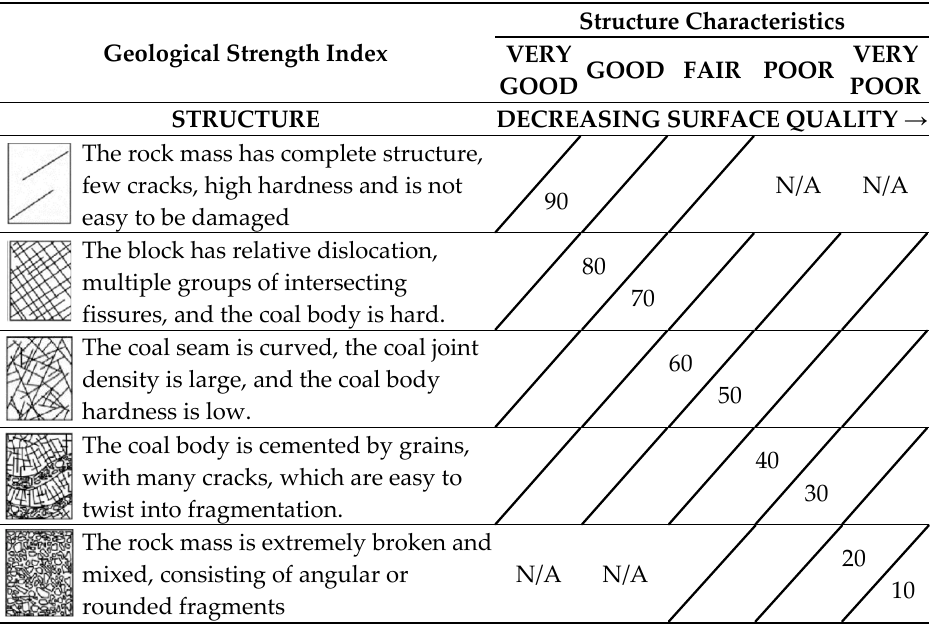
Table 1. Reference table of geological strength index.